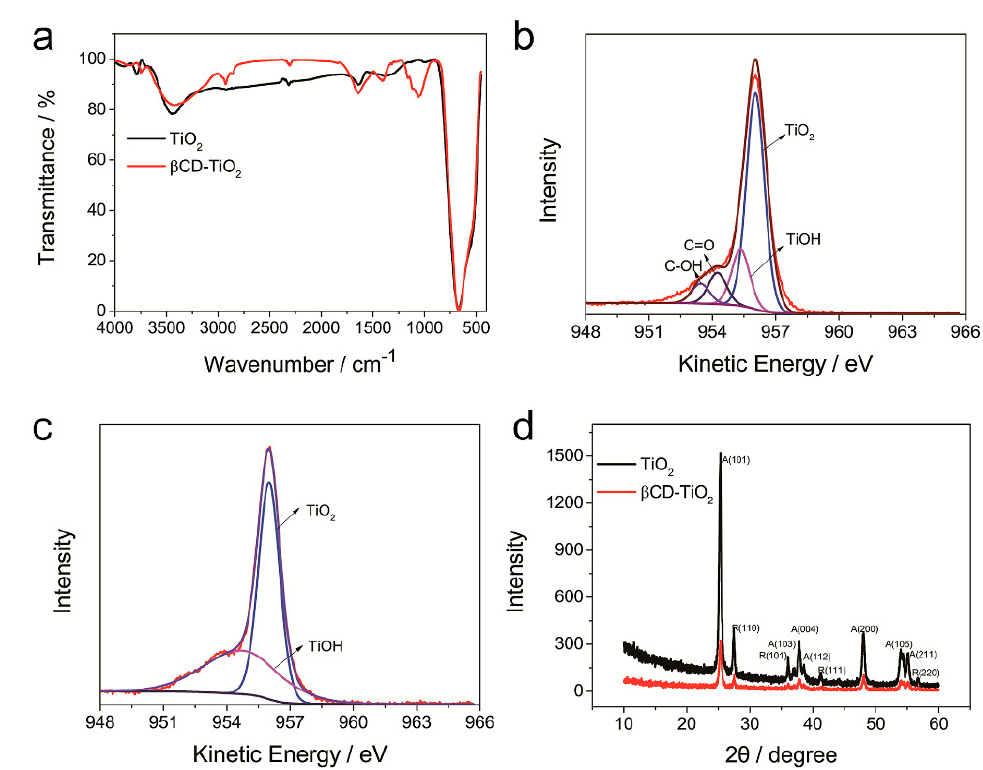
Figure 3. Spectra of β -CD-TiO 2 and TiO 2 : ( a ) FT-IR spectrum of TiO 2 and β -CD-TiO 2 ; ( b ) XPS spectrum of β -CD-TiO 2 in the O1s interval; ( c ) XPS spectrum of TiO 2 in the O1 s interval; ( d ) XRD spectrum of TiO 2 and β -CD-TiO 2 .